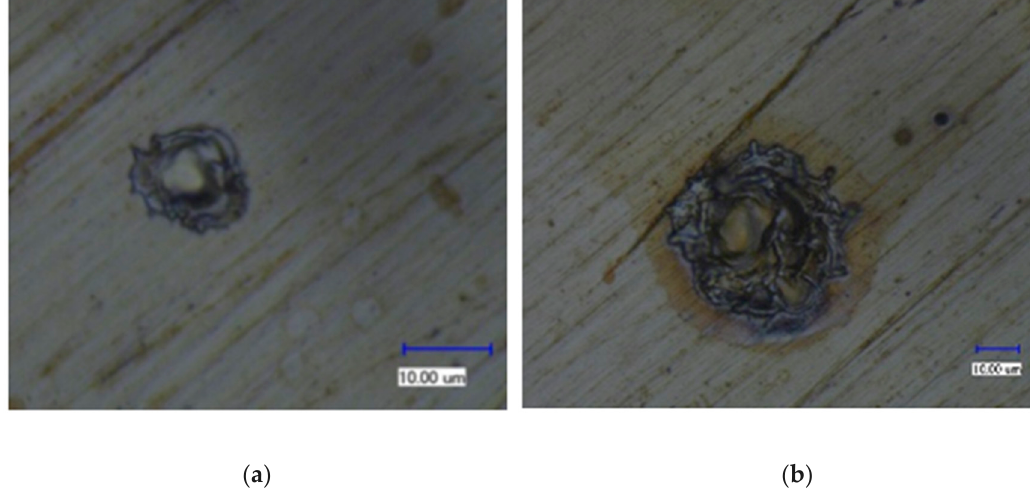
Figure 8. Surface morphology of a discharge crater when the workpiece was connected to a positive electrode: ( a ) the discharge duration was 0.63 μ s and ( b ) the discharge duration was 11.5 μ s.